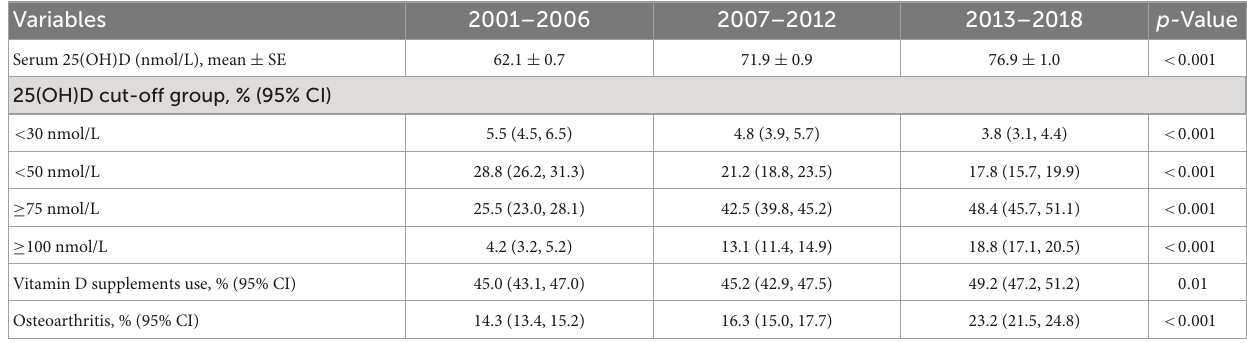
TABLE 2 Serum 25(OH)D concentrations and prevalence of serum 25(OH)D concentrations below or above various clinical cut-offs, vitamin D supplement use, osteoarthritis in this study stratified by NHANES survey cycles